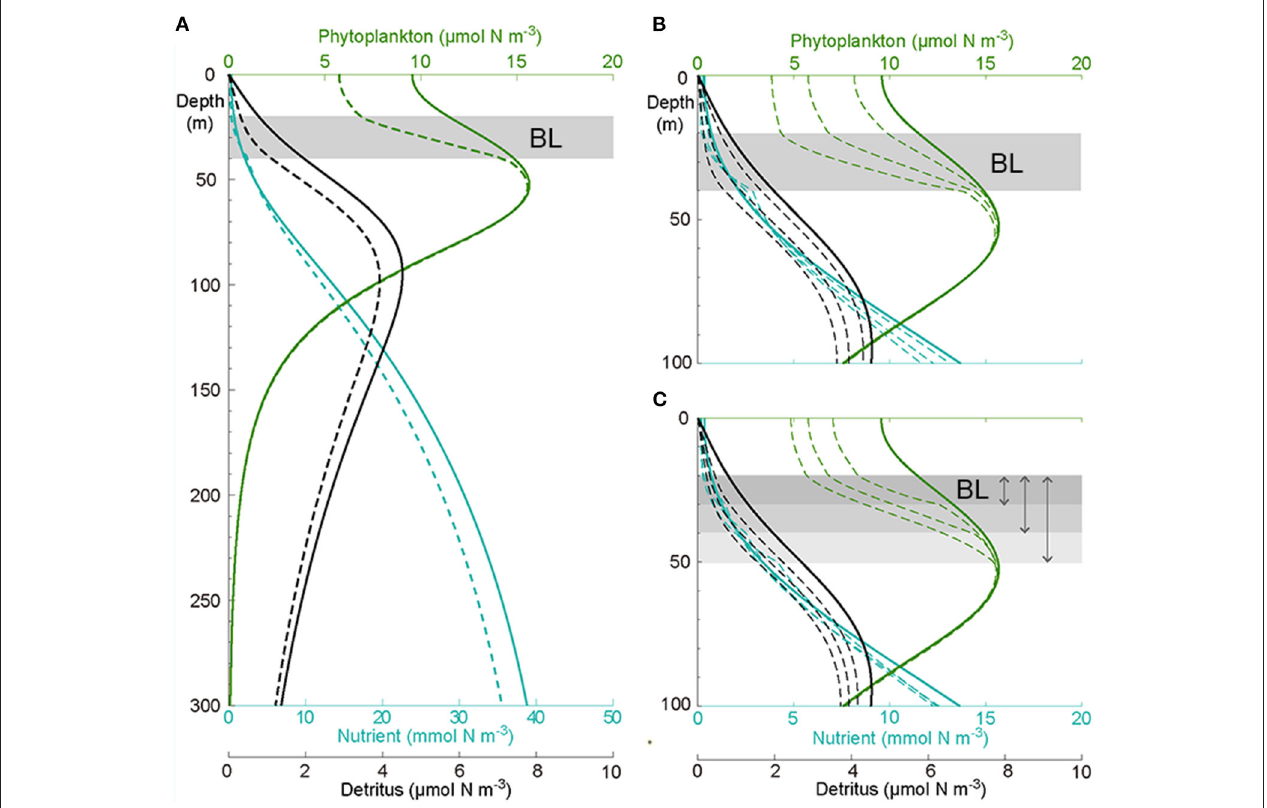
FIGURE 7 | (A) Modeled vertical distribution of nutrients (blue), phytoplankton (green), and detritus (black) not affected (solid) and affected by the BL (dashed) in the upper 300m. Sensitivity of the model solutions to the (B) vertical diffusion [1, 2, 4 ( × 10 − 5 m 2 s − 1 )] and (C) thickness (10, 20, and 30m) of the BL, only the upper 100m are